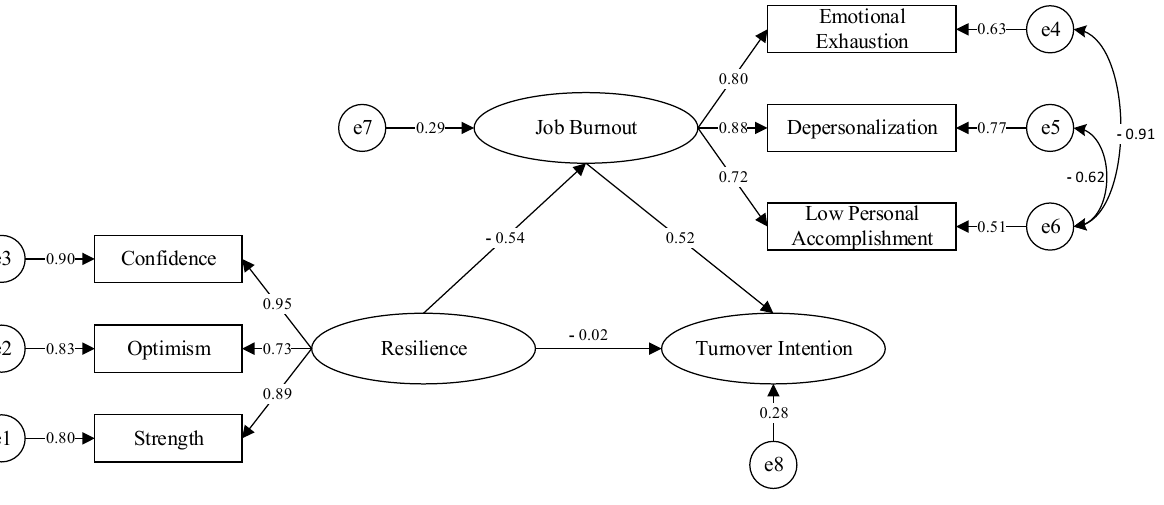
Figure 3. Mediating effect model.